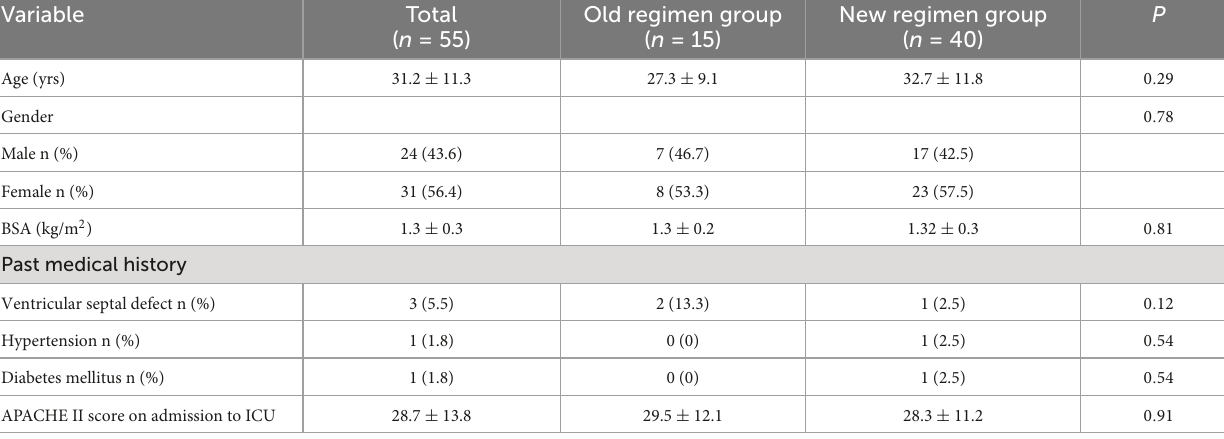
TABLE 1 Demographic characteristics of the new and old regimen group of AFM supported with